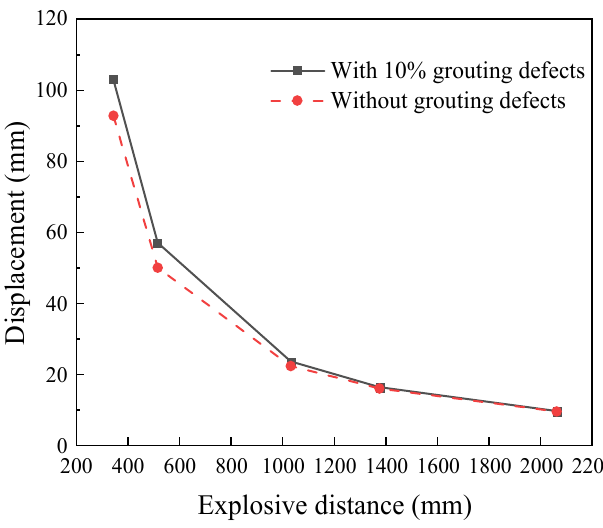
Figure 24. Peak displacements of the shear wall with different explosive distances.